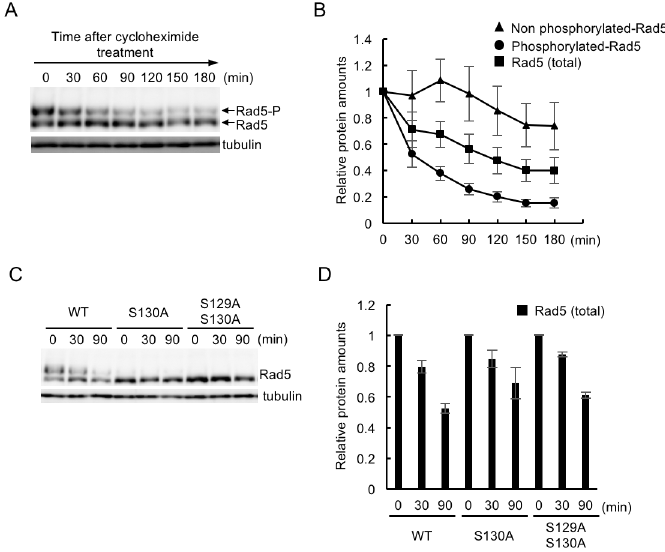
Fig 5. Rapid decay of S130 phosphorylation species. (A) RAD5-Myc cells were asynchronously grown in YPDA, and were then treated with CHX (400 μ g/ml) for the indicated times to shut off transcription. The stability of Rad5 was examined by Phos-tag western blotting. (B) The band intensities of phosphorylated and unphosphorylated Rad5 shown in (A) were quantified (n = 3). Normalized levels of each band relative to 1.0 at time 0 are shown. Error bars represent the standard errors of the three independent experiments. (C) Cells grown to early log phase at 30˚C were transferred into YPDA containing CHX. Samples were obtained at 0, 30, and 90 min after the addition of CHX, and were then subjected to Phos-tag western blotting. (D) The overall band intensity of each lane in (C) was quantified, and the Rad5 protein level remained after the addition of CHX was shown relative to 1.0 at time 0. Error bars represent the standard errors of the three independent